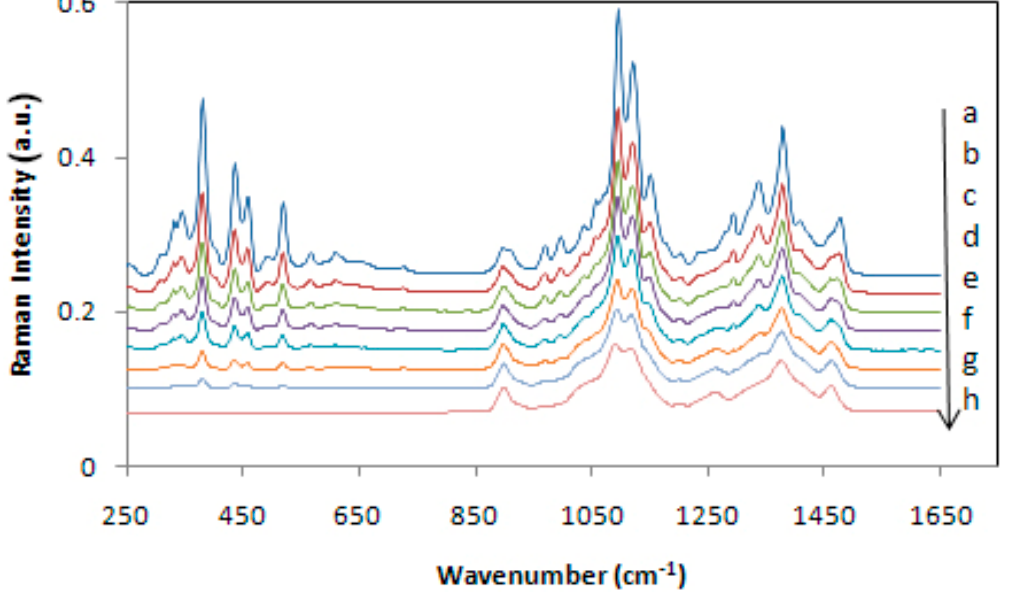
Figure 2. Calibration set Raman spectra after subtracting amorphous spectrum in the region 250–700 cm − 1 ; (a) control, cotton microcrystalline cellulose, and plots (b) to (h) are spectra of mixture 1, mixture 2, mixture 3, mixture 4, mixture 5, mixture 6, and 120-min ball milled cellulose, respectively. Note that in the case of 120-min spectrum the intensities below 700 cm − 1 are all zero because of the subtraction. Spectra were offset on the intensity scale for display purposes. Reproduced with permission from Ref. [23]. Copyright Springer Nature